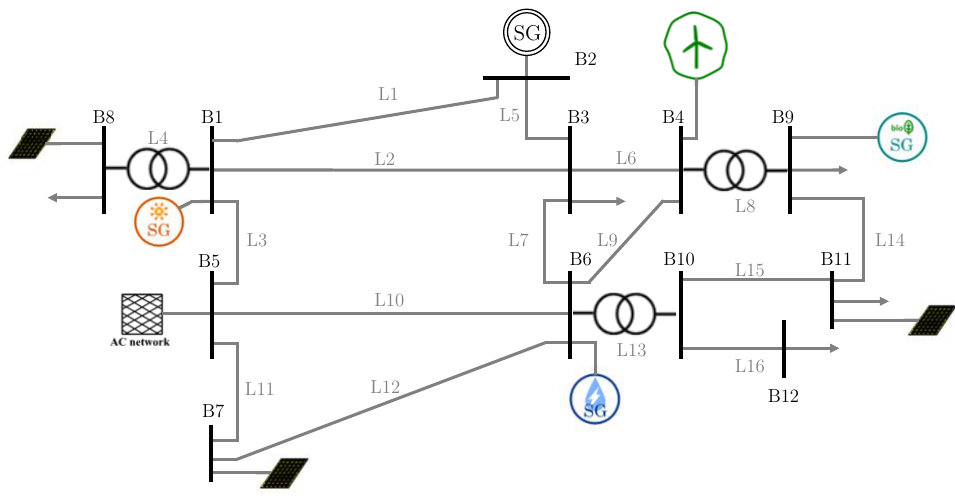
Figure 3. A 12-node network for test